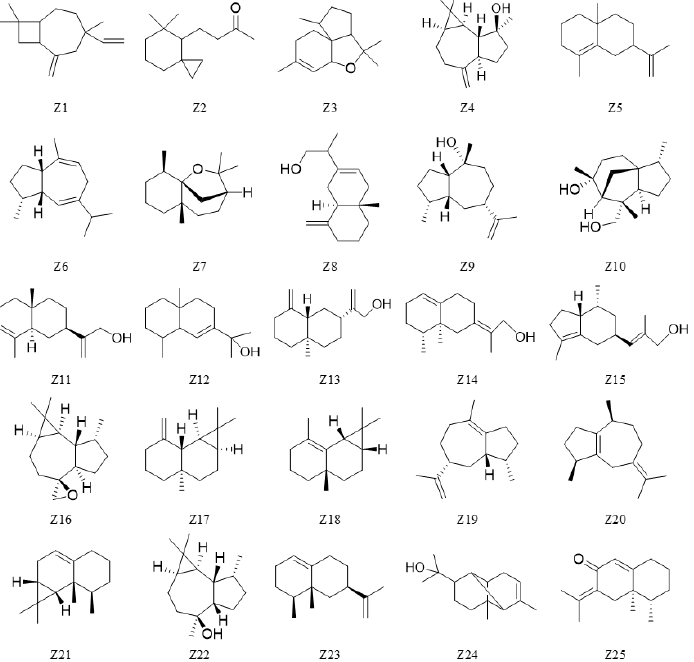
Figure 7. Chemical structure of 25 blood compounds identified in serum samples. From the statistical results of the total peak number and area across 4 administration time points shown in Table 1, it can be seen that the detectability of the blood components in both the intraperitoneal injection and inhalation groups reached their highest level at the time point of 10 min. We identified 25 original AEO compounds in the serum of the intraperitoneal injection group, 13 of which were identified in the inhalation group, including 24 sesquiterpenes (except Compound Z2). Compounds Z16, Z4 and Z23 were the main components in the intraperitoneal injection group (31.45%), and Compounds Z16, Z25 and Z23 were the major components in the inhalation group (4.89%). It was speculated from the blood compound results that the greater variety and greater content of the injected blood components might be the reason that the sleep-promoting effect of intraperitoneal injection was better than that of AEO inhalation.